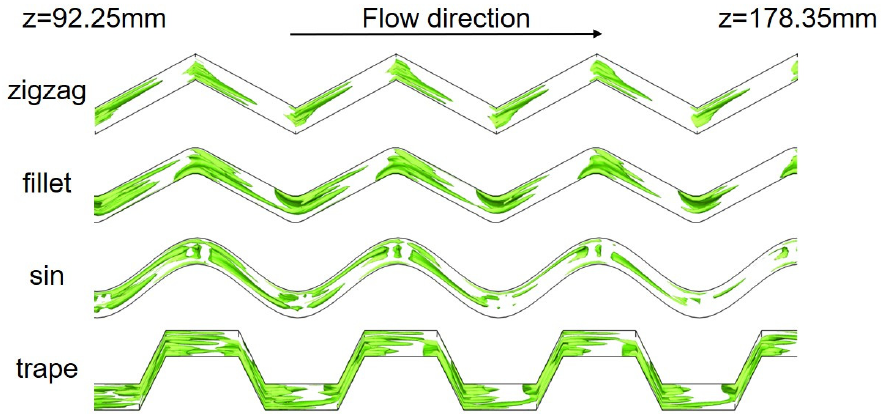
Figure 10. Vortex structure of the hot fluid among four wavy channels.